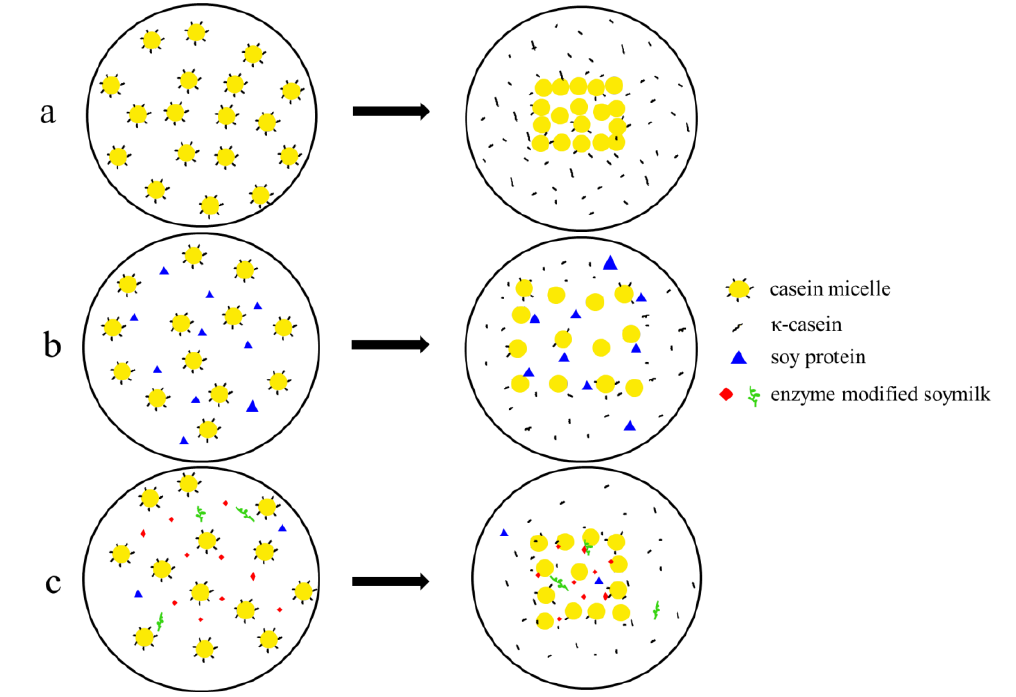
Figure 4. Schematic diagram of rennet induced gelation of different mixtures. a , skim milk; b , skim milk and soymilk; c , skim milk and enzyme modified soymilk.